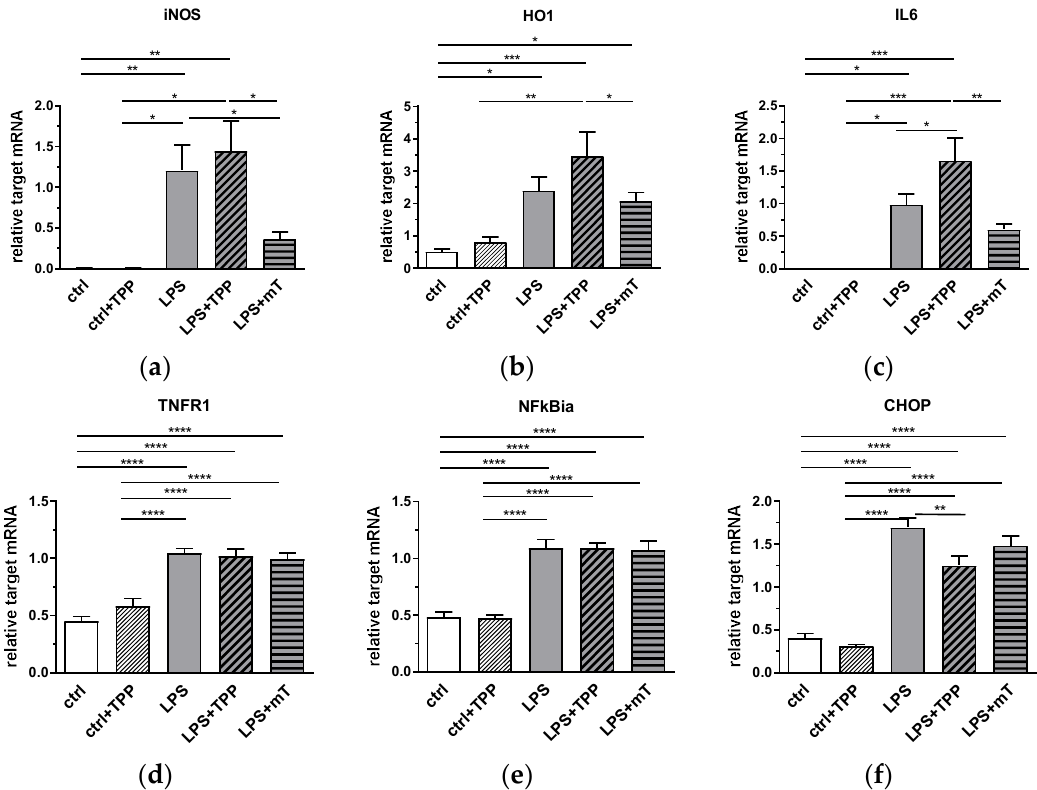
Figure 3. Effect of lipopolysaccharide (LPS, 1.75 mg/kg), methyltriphenylphosphonium chloride (TPP, 50 nmol/kg) and mitoTEMPO (mT, 50 nmol/kg) on gene expression of iNOS ( a ), HO1 ( b ), IL-6 ( c ), TNFR1 ( d ), NFkBia ( e ), and CHOP ( f ) in rat liver. After LPS injection, gene expression levels of all mediators increased ( a – f ). MitoTEMPO treatment decreased the mean values of iNOS ( a ) and IL-6 ( c ). An increase is seen in IL-6 expression in the LPS+TPP group compared to the other LPS groups. All data are normalized for the expression levels of the reference genes (cyclophilin A and hypoxanthine-guanine phosphoribosyl transferase (HPRT)) and expressed as fold changes relative to the internal standard. * p < 0.05, ** p < 0.01, *** p < 0.001. One-way analysis of variance (ANOVA), Fisher’s least significant difference (LSD), n = 3-8, mean ± SEM, * p < 0.05, ** p < 0.01, *** p < 0.001. Abbreviations: inducible nitric oxide synthase (iNOS), heme oxygenase 1 (HO-1), interleukin 6 (IL-6), tumor necrosis factor receptor 1 (TNF-R1), nuclear factor kappa B inhibitor alpha (NFkBia), CCAAT/enhancer-binding protein homologous protein (CHOP).